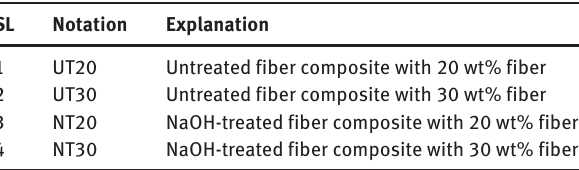
Table 1 Notations used in composite